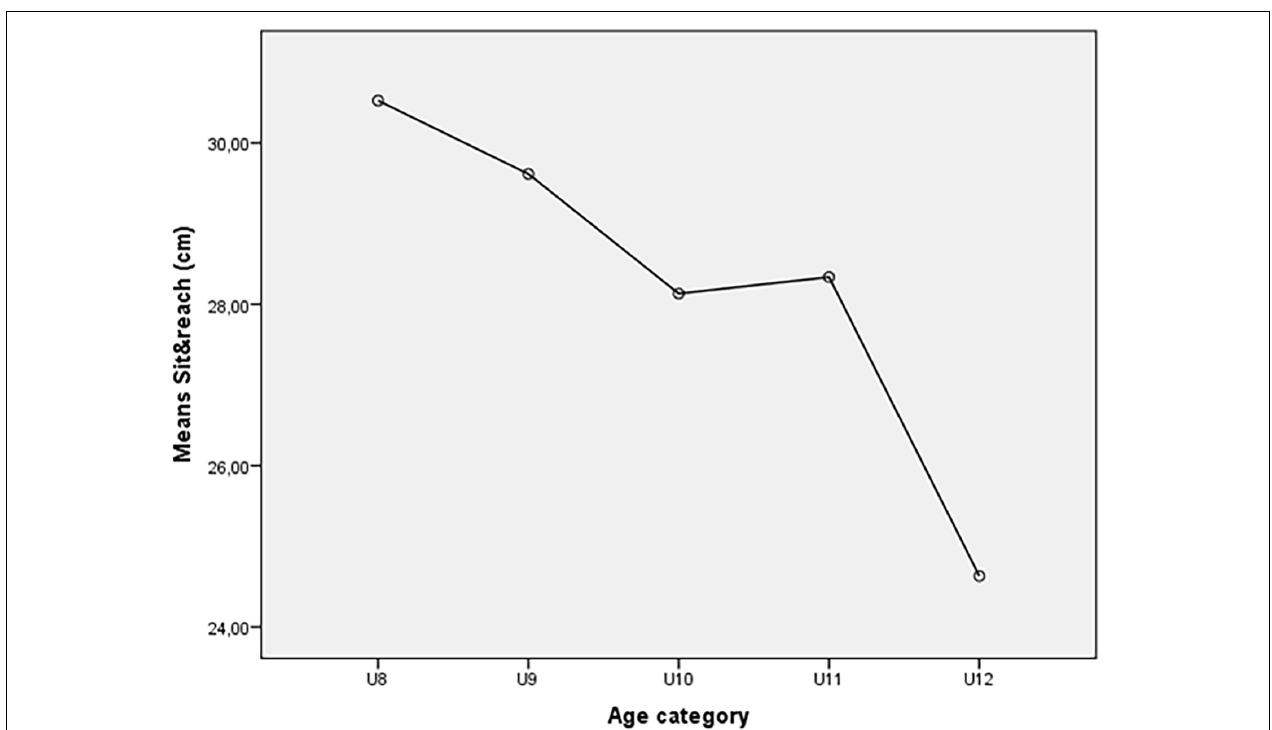
FIGURE 1 | Representation of hamstring flexibility decrease across age. The most significant hamstring flexibility decline is between U11 and